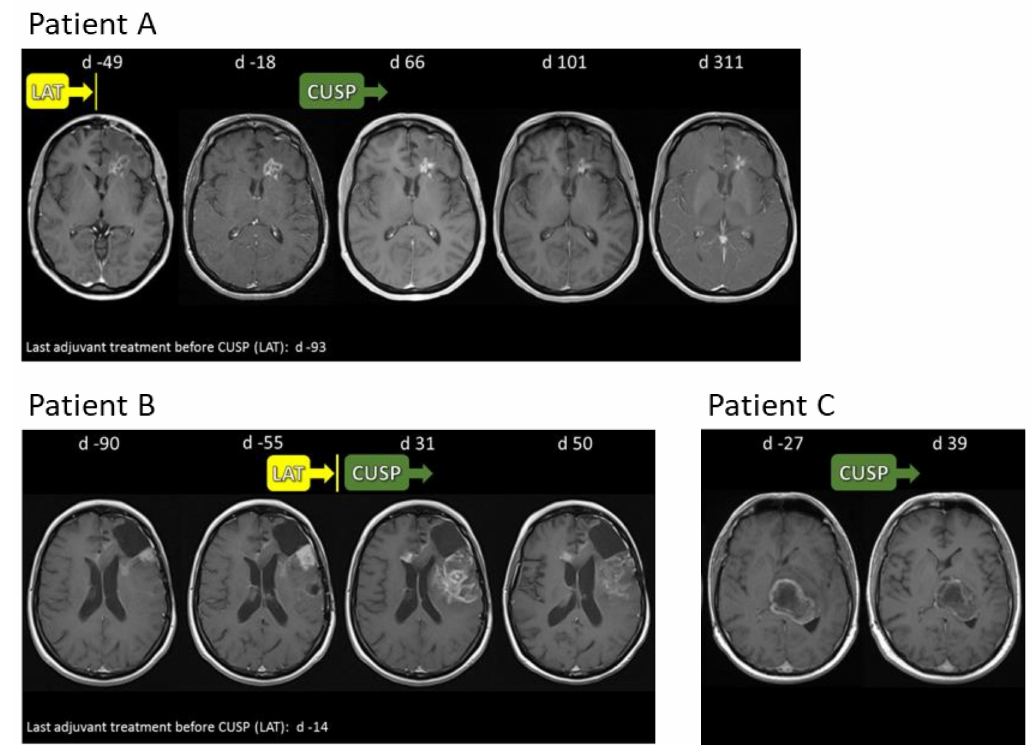
Figure 4. Representative T1-weighted MRIs of patients ( A – C ) after application of contrast media. LAT: Last adjuvant treatment before initiation of